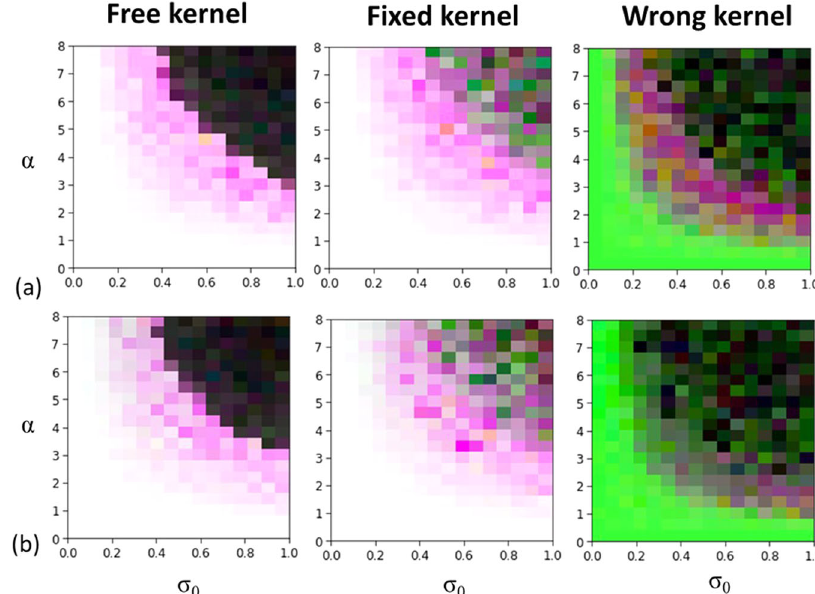
Fig. 8 Effect of kernel constraints on reconstruction. Shown are results for a model 1 and b model 2 for free kernel (left column), kernel constrained around the characteristic length scale (central column), and kernel constrained around the value twice larger than characteristic length